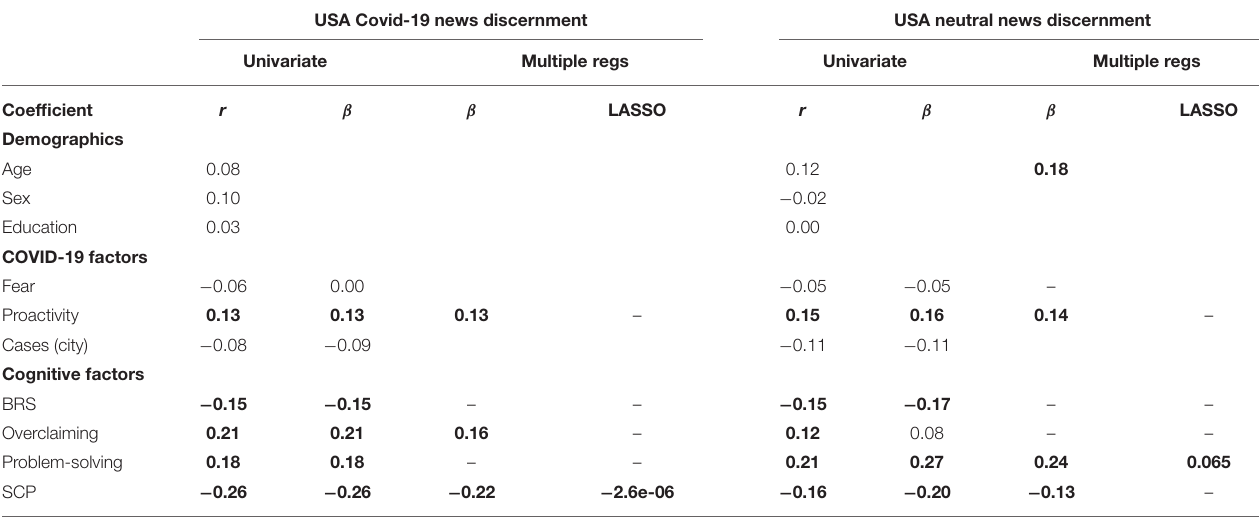
TABLE 2 | Correlation, standardized univariate regression, multiple stepwise, and Lease Absolute Shrinkage and Selection Operator (LASSO) coefficients for the American sample.